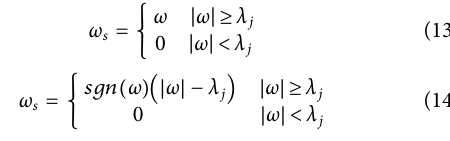
FIGURE 2 The fl owchart of the CEEMDAN-WTD.